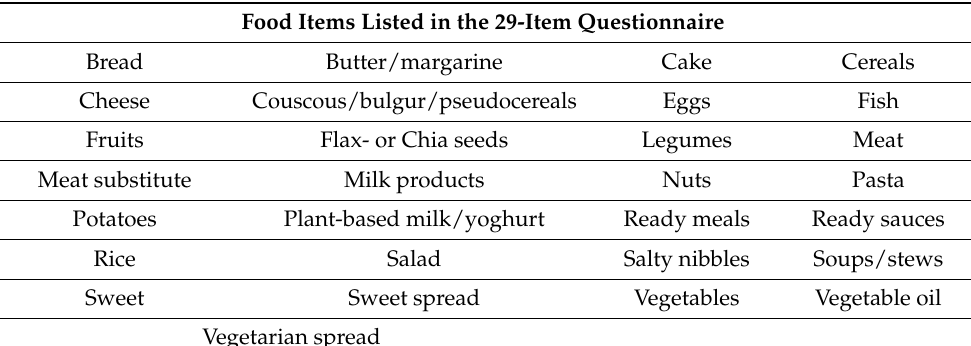
Table 1. Food items listed in the questionnaire to assess nutritional beliefs about stress-relieving